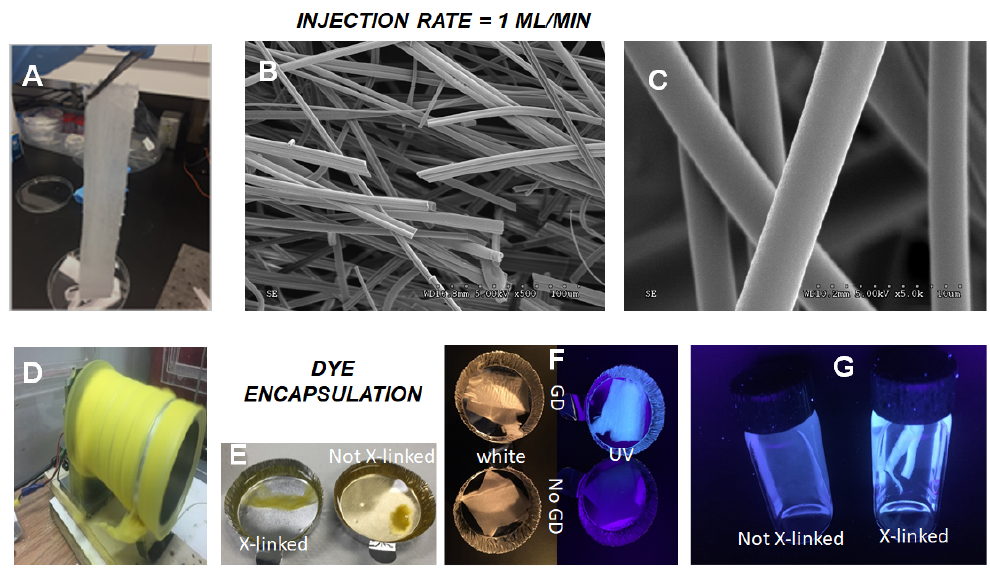
Figure 5. Mat of fibers ( 1 :IPDA = 83:17 in DMF) obtained at high injection rate (1 mL/min) ( A ) and SEM pictures of the fibers ( B , C ). Cylindrical collector with fibers containing a yellow dye after 5 min of electrospinning ( 1 :IPDA = 66:33 in DMF, injection = 1 mL/min) ( D ) and same fibers immersed in THF ( E , before and after cross-linking). Pictures of fibers containing GDs ( 1 :IPDA:GD = 82:16:2 in DMF electrospun at 1 mL/min) under white and UV light ( F ) compared with fibers devoid of GDs. GD-containing fibers before and after cross-linking immersed in THF, under UV light ( G ).